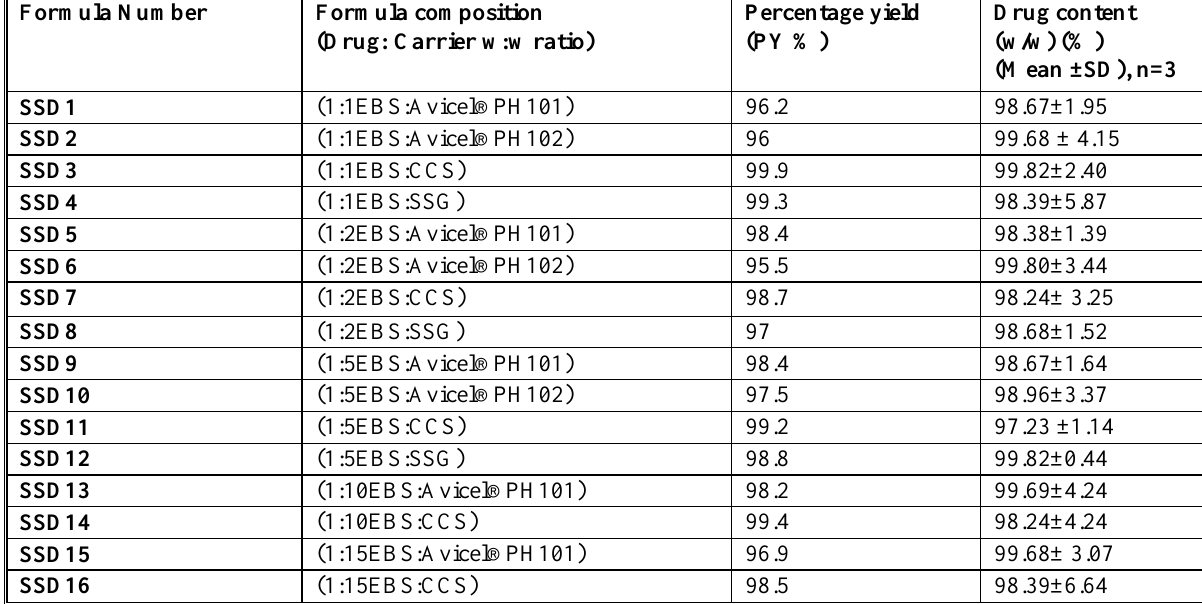
Table 2. Percentage yield and drug content of prepared SSDs Formula Number Formula